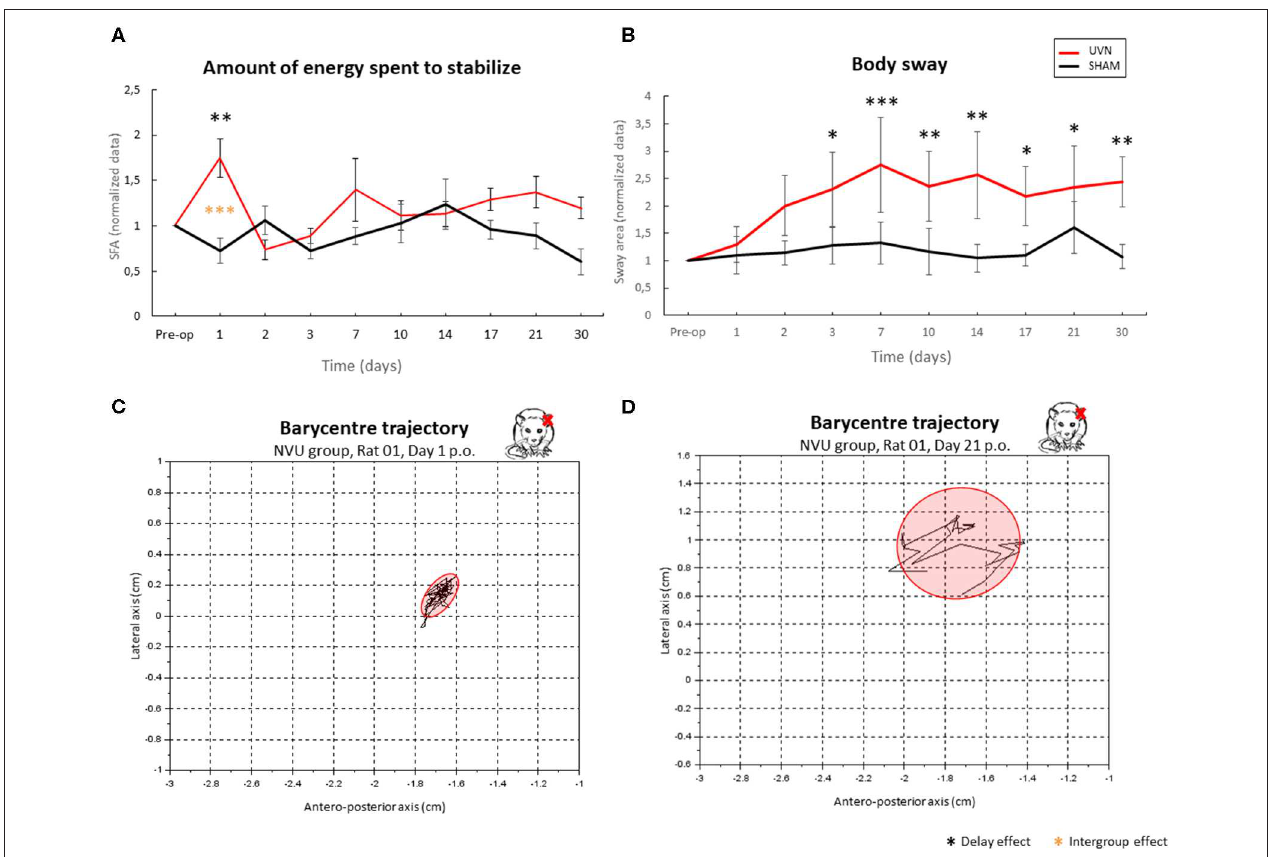
FIGURE 7 | Use of posturographic parameters to quantify postural instability in a UVN rodent model. (A) quantification of the energy spent for posture stabilization. (B) body sway. (C,D) examples of barycentre plots observed in a representative NVU rat in acute (C) and compensated (D) period. The NVU group spends significantly more energy to stabilize on the first day post-UVN ( p < 0.001); this energy is quantified by a ratio between the velocity of the barycentre and the surface of the confidence ellipse. It then stabilizes from D2 to D30 and becomes similar to that of the SHAM group, in which there is little variation at any time. The body-sway (B) is significantly higher in UVN rats from D3 to D30 and remains stable in SHAM rats. In (C) , we can see the representation of the displacement of the barycentre as well as its confidence ellipse at a time when the animal spends a lot of energy stabilizing its posture: the animal is stable but the displacement of its barycentre shows efforts spent to concentrate the position of its barycentre in the surface of the ellipse. In (D) , the same parameters are represented at a compensated delay: the animal is unstable (high surface area of confidence ellipse), and the dispersion of the path of its barycentre shows little effort applied to restrict the movement of the barycentre in a small area, that underlies a new postural strategy. Delay effect refers to significative differences with the preoperative condition; intergroup effect means that a significative difference was found between UVN and SHAM group (* p < 0.05; ** p < 001; *** p <